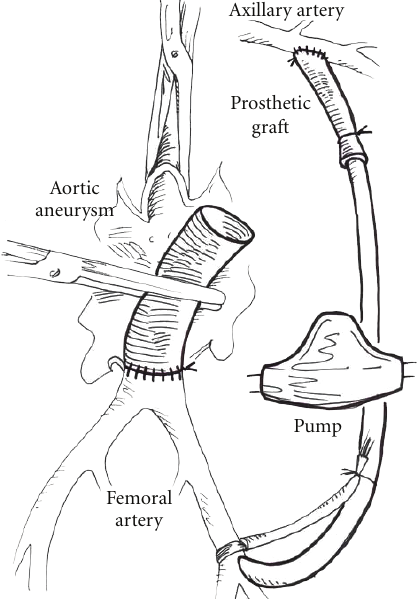
Figure 1: A construction of axillofemoral bypass with a centrifugal pump in the